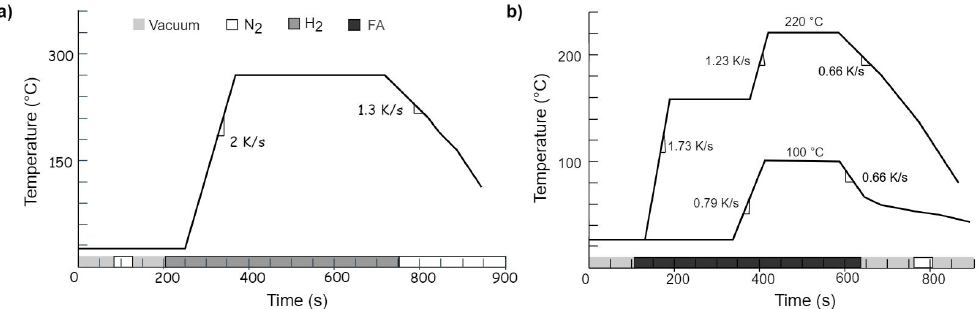
Figure 4. Temperature profiles for reducing Cu oxides using ( a ) hydrogen gas at 270 ◦ C and ( b ) formic-acid vapor at 220 ◦ C. The lower curve in ( b ) labeled with 100 ◦ C represents the production of Cu